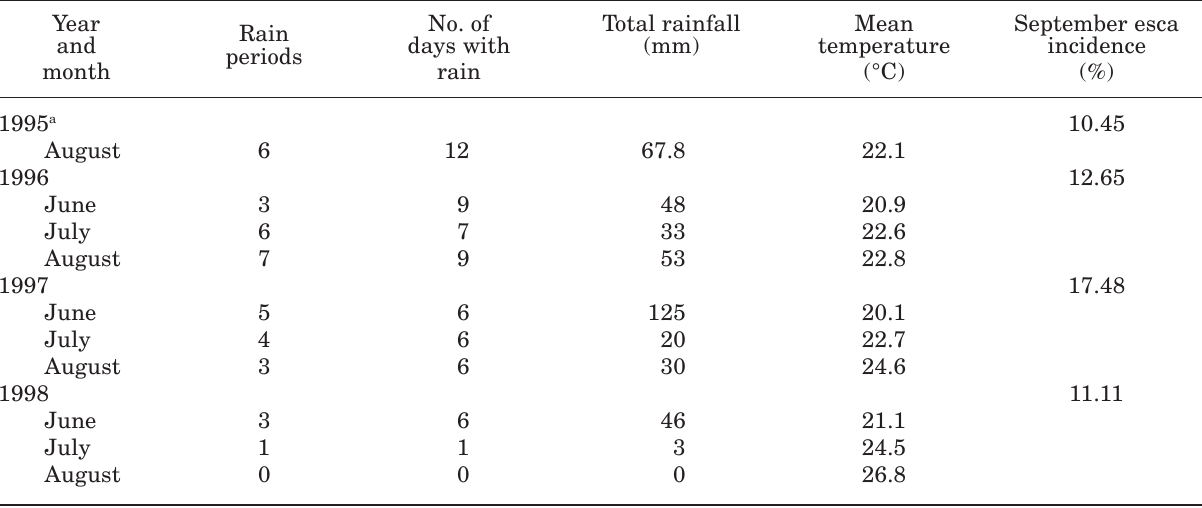
Table 8. Mean monthly temperature, monthly rainfall from June to August and incidence of esca in three vineyards at Castelnuovo Berardenga (Siena),